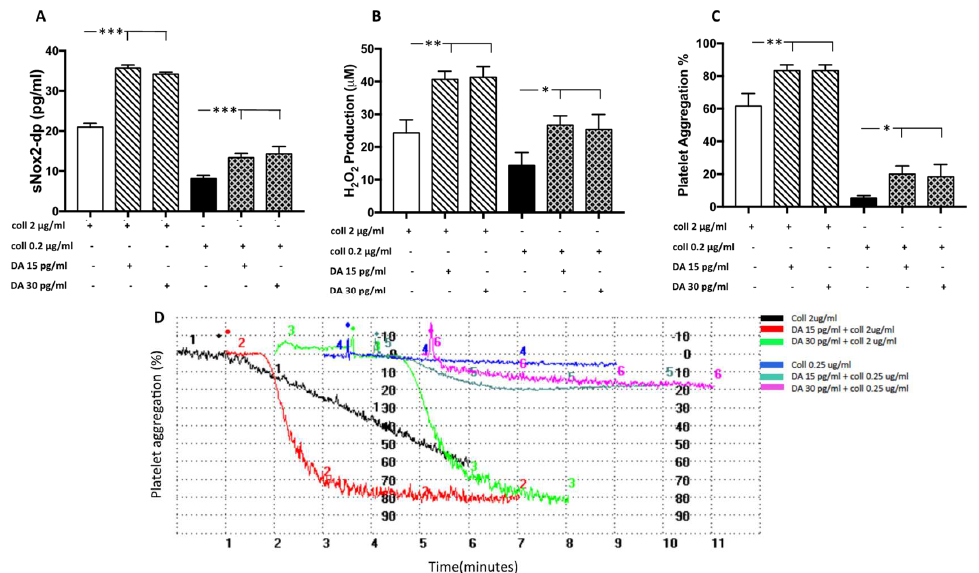
Figure 4. Dopamine-induced platelet aggregation and oxidative stress. sNOX2dp concentration ( A ),